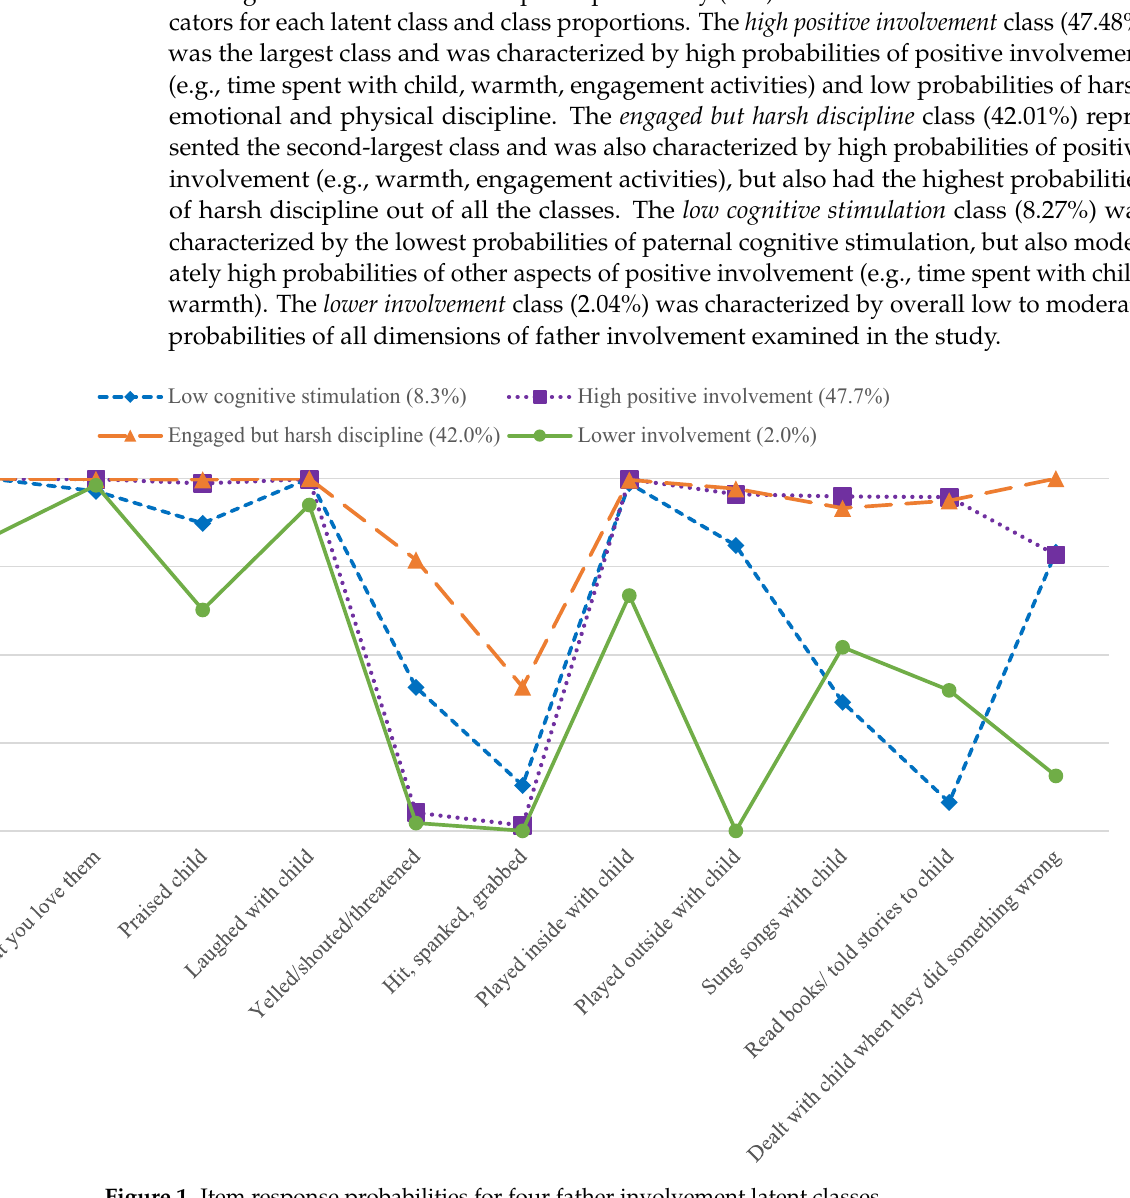
Figure 1. Item response probabilities for four father involvement latent classes.